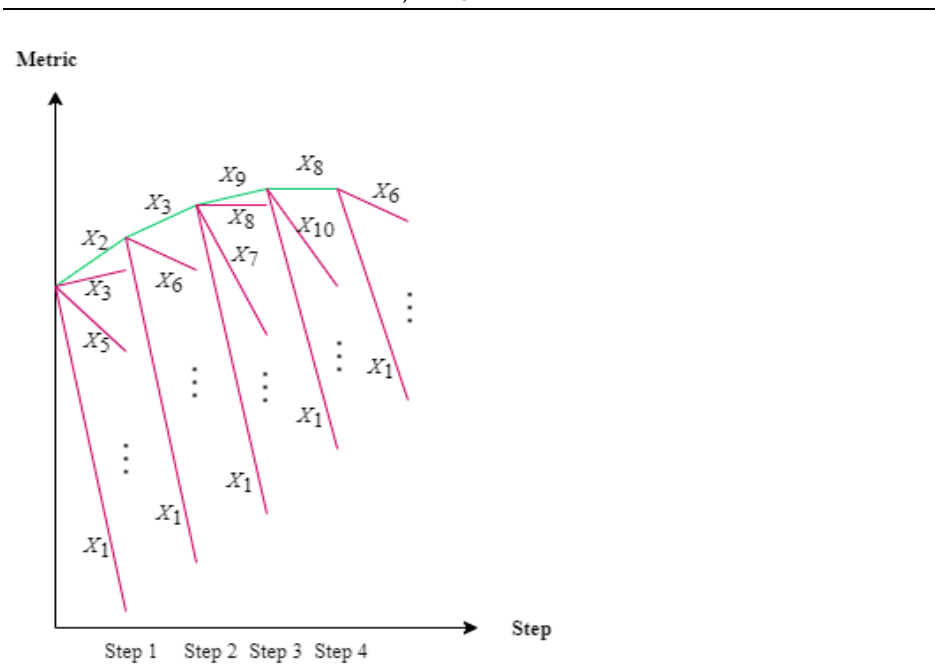
Figure 2. The graphical representation for 1-max-out for an illustrative example.